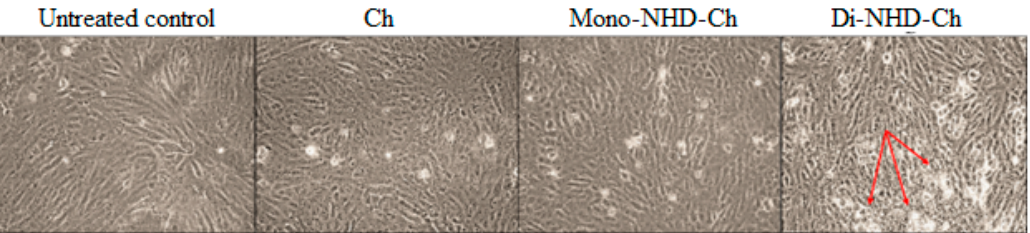
Figure 6. Wi-38 cell morphology after 72 h incubation with 0.5 mg of Ch, Mono-NHD-Ch, and Di-NHD-Ch. Arrows refer to cell damage.